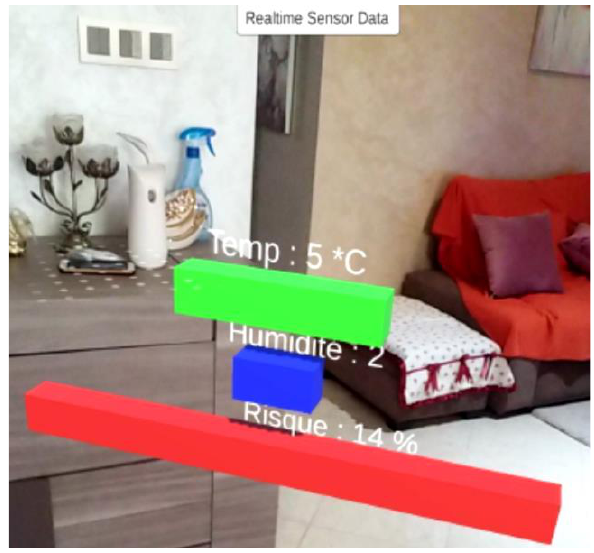
Figure 6. Visualization of real-time information from